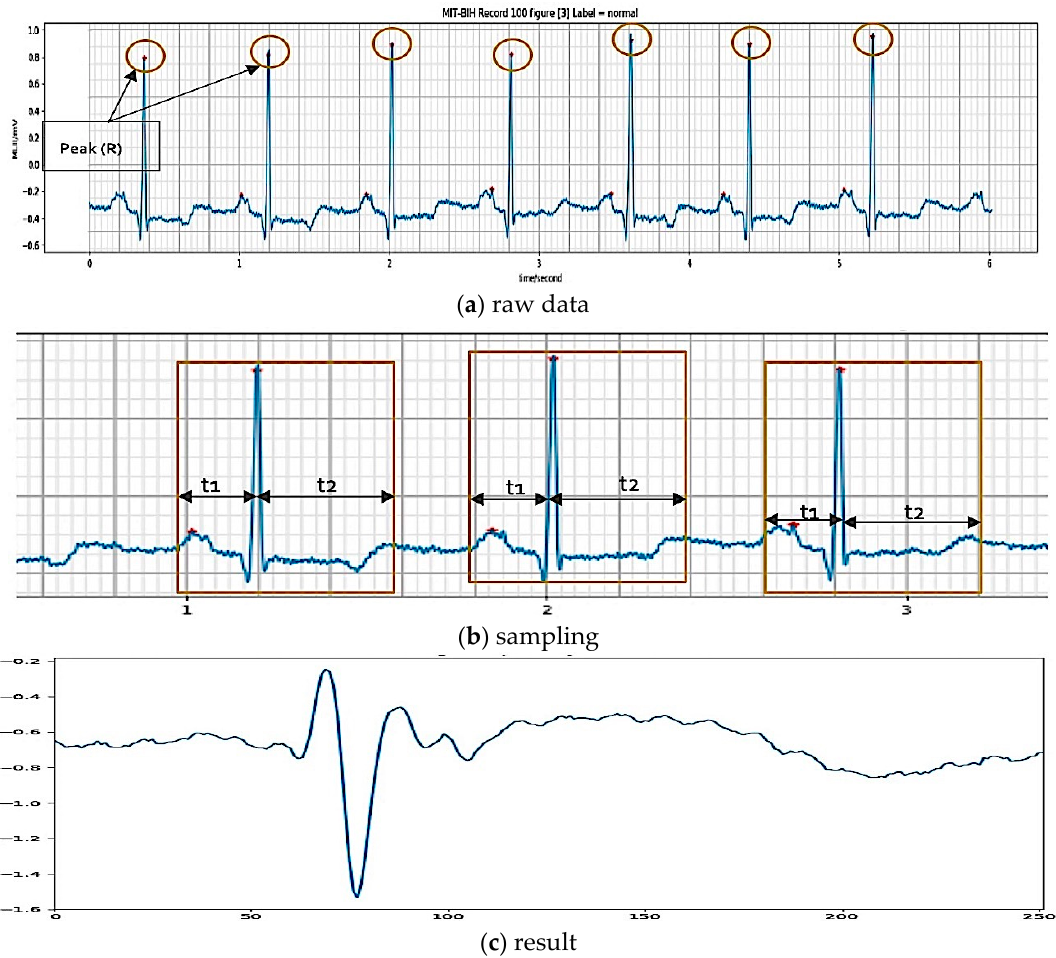
Figure 2. Beat segmentation.